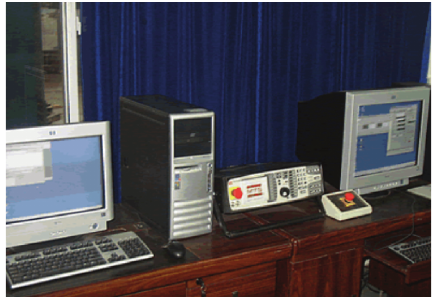
Figure 1: Testing machine control system.